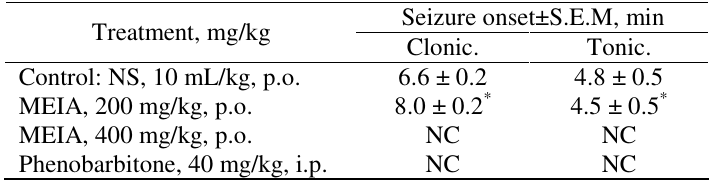
Seizure onset±S.E.M, min Clonic. Tonic.